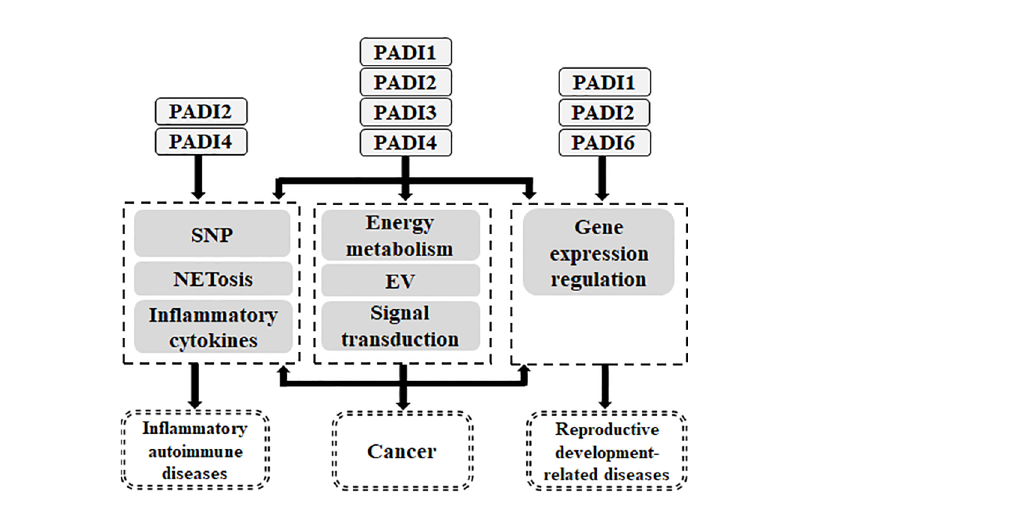
FIGURE 5 Relationship between PADI family and human diseases. The genetic variation of PADI family will endow with the susceptibility of in fl ammatory autoimmune diseases and cancer. PADI family can participate in in fl ammatory autoimmune diseases through NETosis and in fl ammatory cytokines. PADI family can participate in cancer through NETosis, in fl ammatory cytokines, energy metabolism, EV, signal transduction and gene expression regulation. PADI family can participate in reproductive and development-related diseases through gene expression regulation.